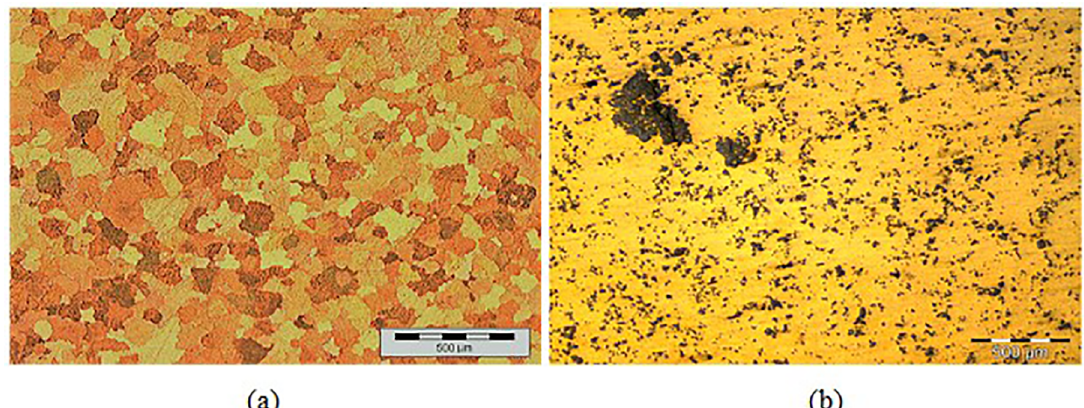
Figure 2. (a) Presence of austenite in the alloy 0.5Nb and (b) precipitates of Nb (black points) in austenitic phase (yellow background) in the alloy with 4Nb.